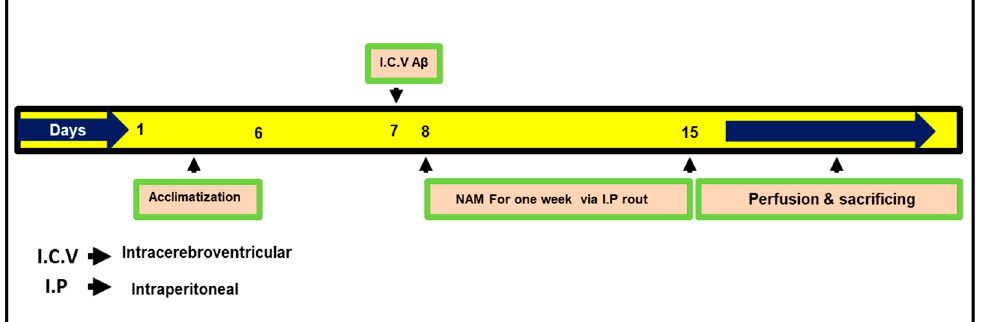
Figure 1. Presenting study plan for the current research work. Mice were divided into three groups (1) Control (2) A β 1–42 (3) NAM (nicotinamide) + A β 1–42